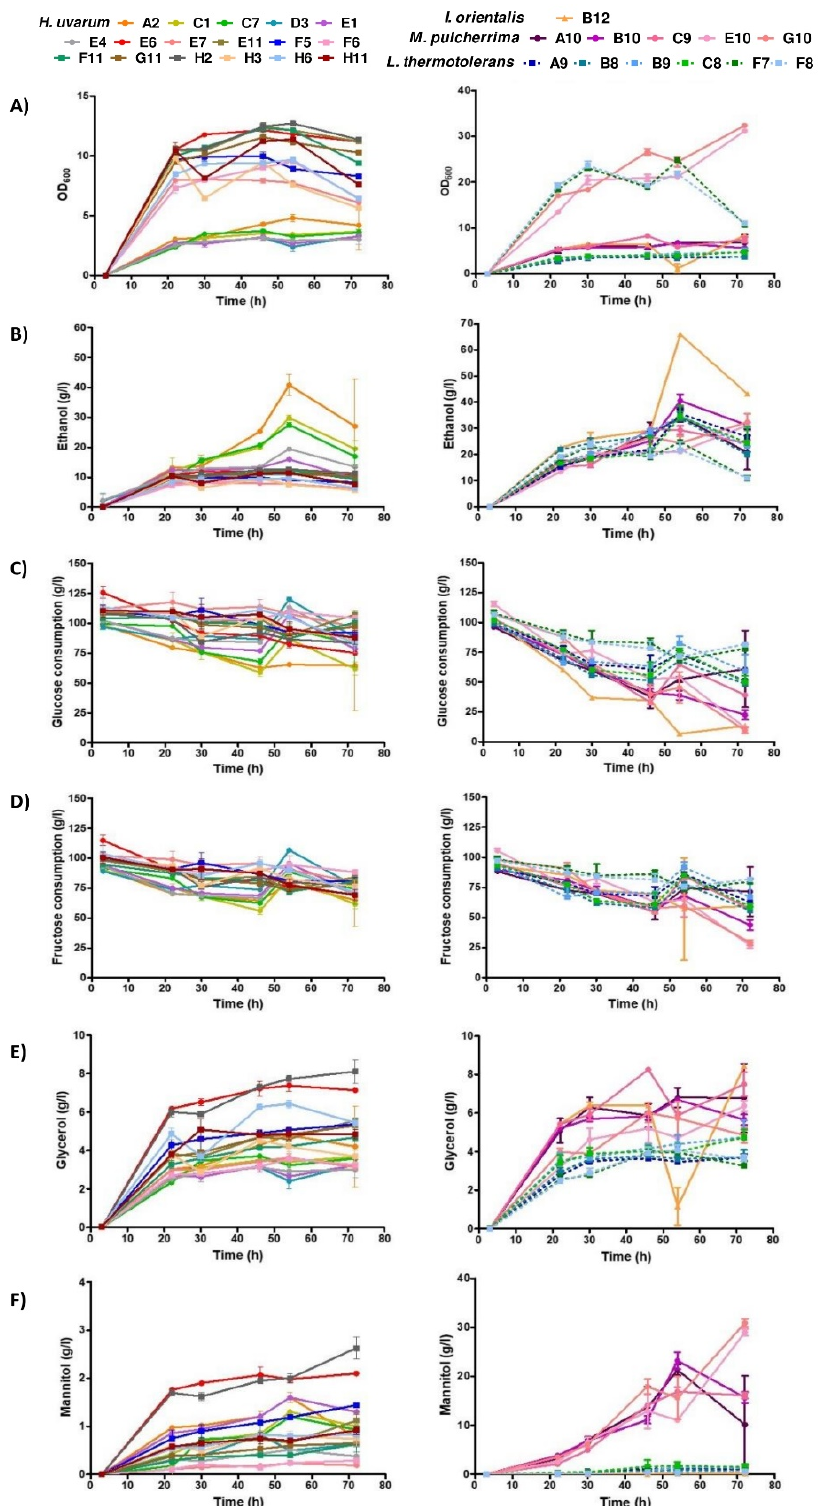
Figure 3. Quantification of metabolite for selected non- Saccharomyces species isolated from Port wine must samples. The growth (OD 600 ) ( A ) was evaluated using a spectrophotometer. Ethanol ( B ) production rate, glucose ( C ), and fructose ( D ) consumption, as well as glycerol ( E ) and mannitol ( F ) concentrations were measured by HPLC. Results represent the mean value ± SD of triplicates, corresponding to three independent growths.